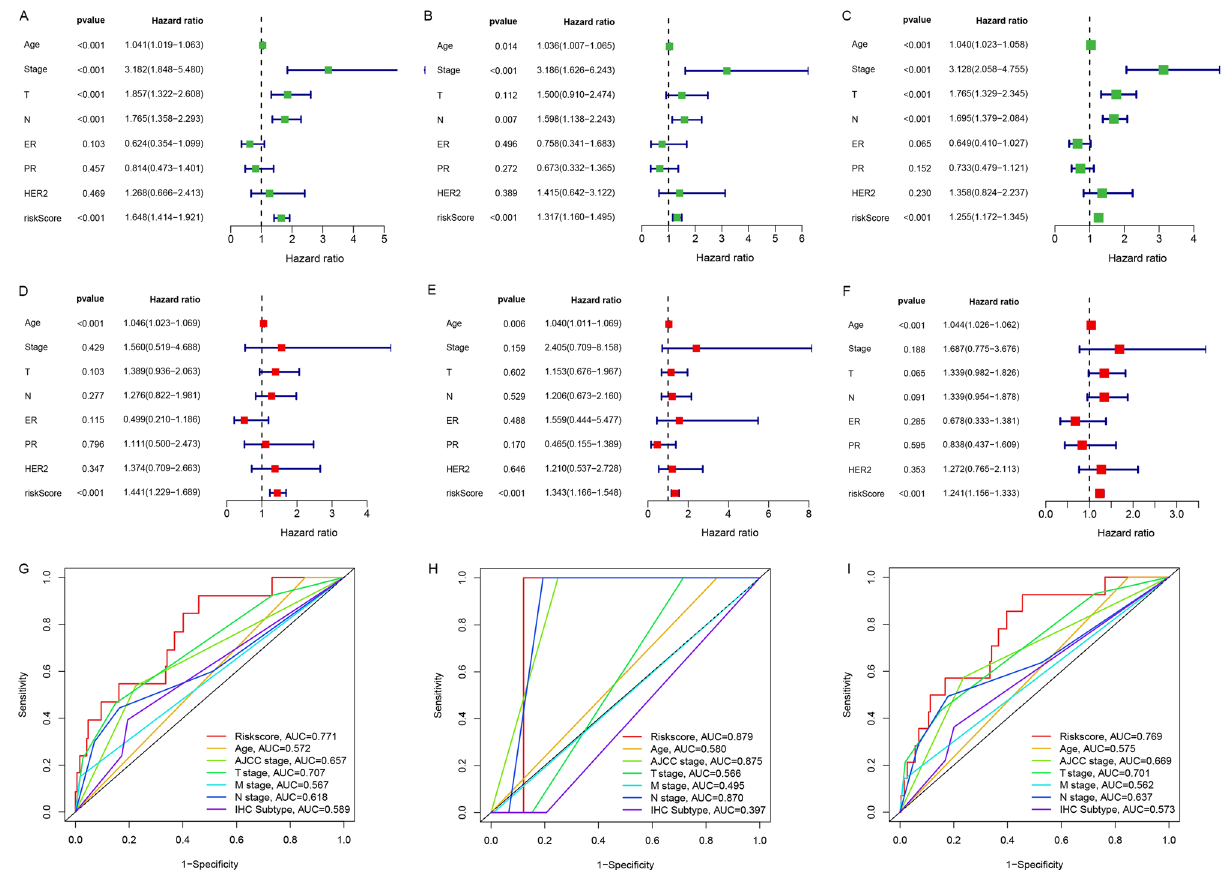
Figure 5. Independent prognostic value of the mitochondrial function-related lncRNA signature. Results of the univariate Cox regression and multivariate Cox regression analysis regarding OS in the training cohort ( A , D ), the validation cohort ( B , E ), and the entire cohort ( C , F ). AUC of ROC curves compared the prognostic accuracy of the risk score and other prognostic factors in the training cohort ( G ), the validation cohort ( H ), and the entire cohort ( I